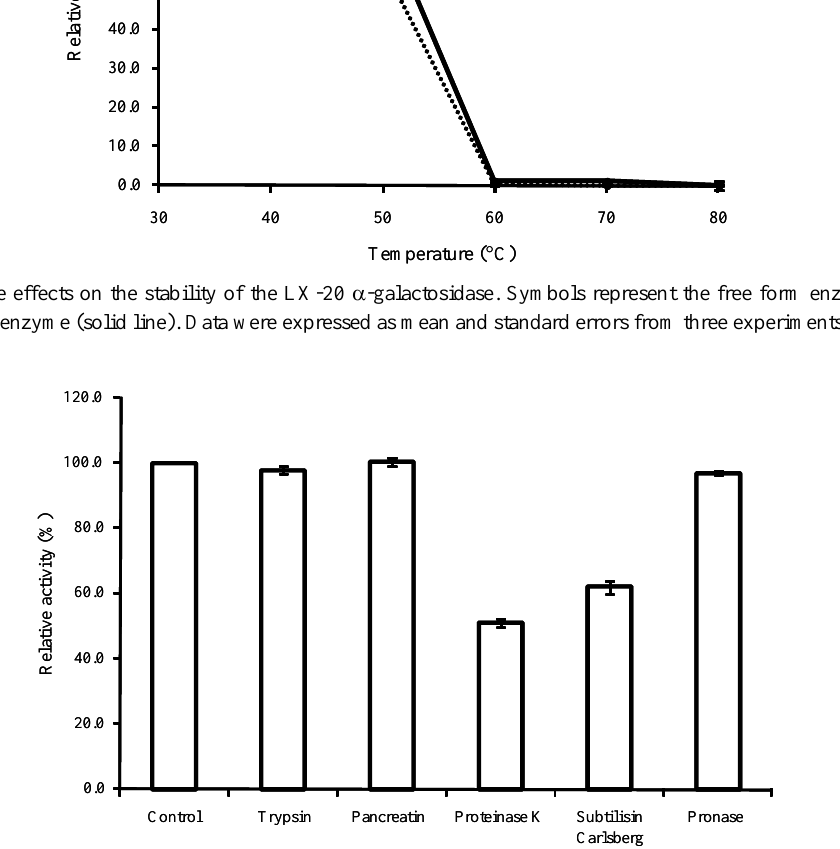
Figure 7. Effect of proteases on the LX-20  -galactosidase activity. The activity of protease-untreated control was defined as 100%, which equates to 0.034  0.009 U/ml. Data were expressed as mean and standard errors from three